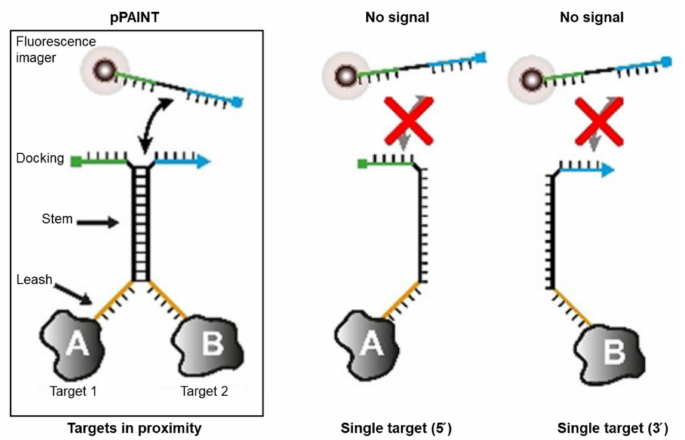
Figure 4. Biosensing strategy of proximity-DNA point accumulation in nanoscale topology (pPAINT) for direct signaling from proximity-induced hybridization induced by bivalent interactions